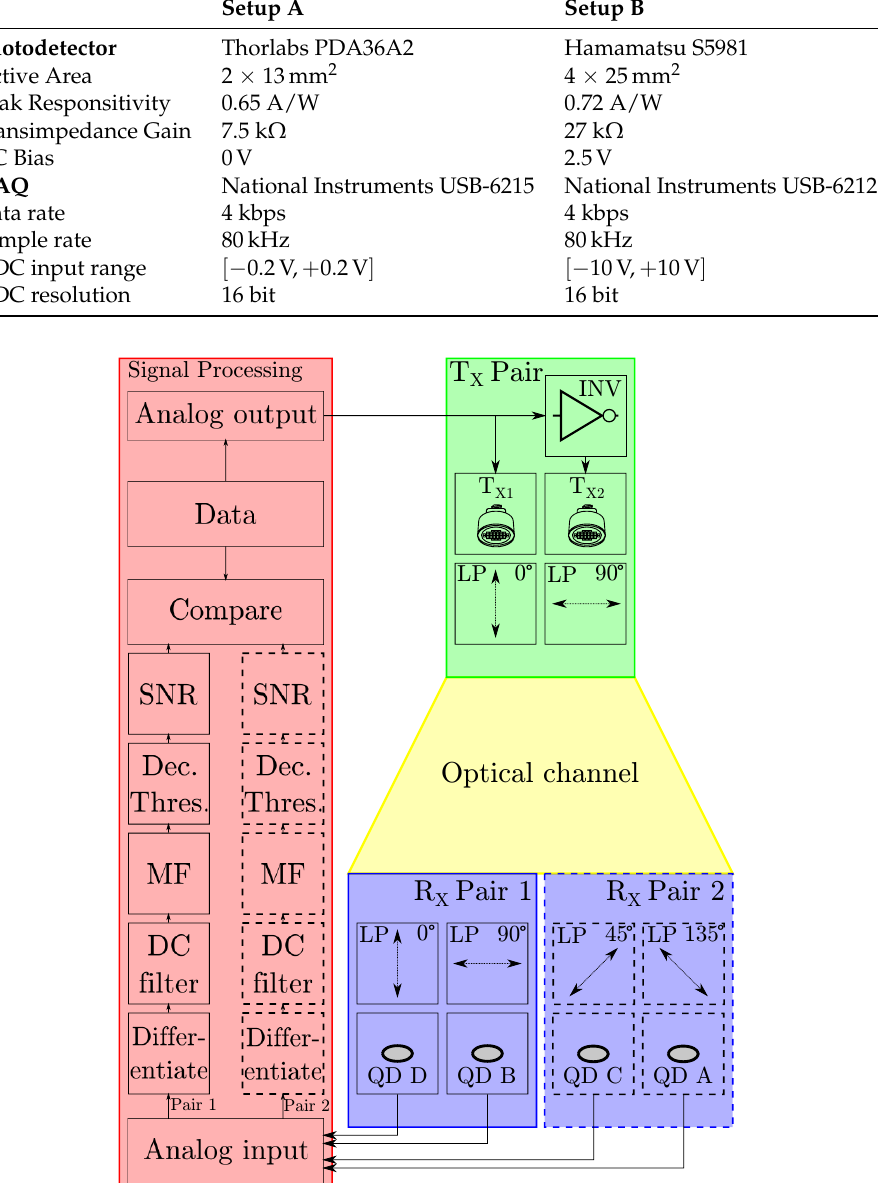
Figure 7. Block diagram illustrating the signal processing chain of both setups. Blocks indicated in striped lines only apply to setup